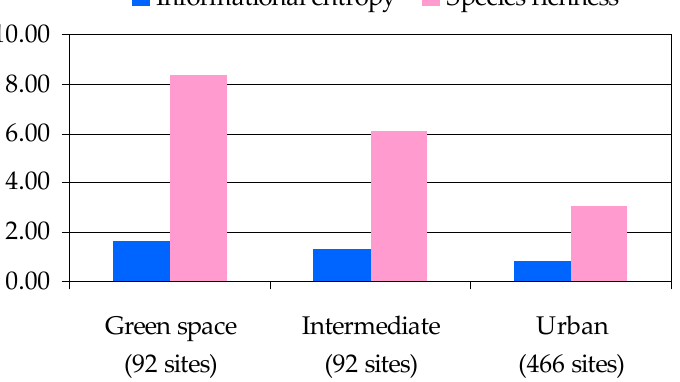
Figure 2. Distribution of Shannon-Wiener’s informational entropy index and species richness across the gradient of urbanization in Annaba, Algeria. The image shows that biodiversity tends to increase when moving from the built-up area towards the natural